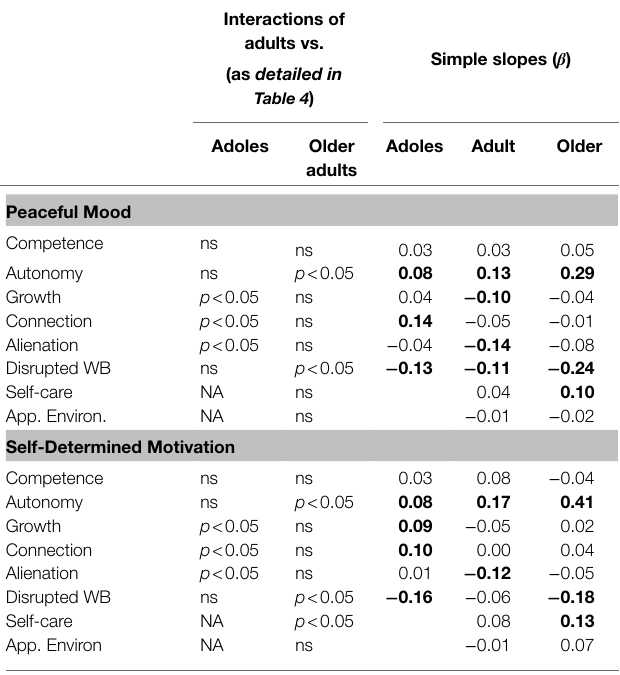
TABLE 5 | Simple slopes contrasting each pair of age groups (adults vs. adolescents and adults vs. older adults) predicting well-being in solitude: peaceful mood and self-determination motivation. Interactions of adults